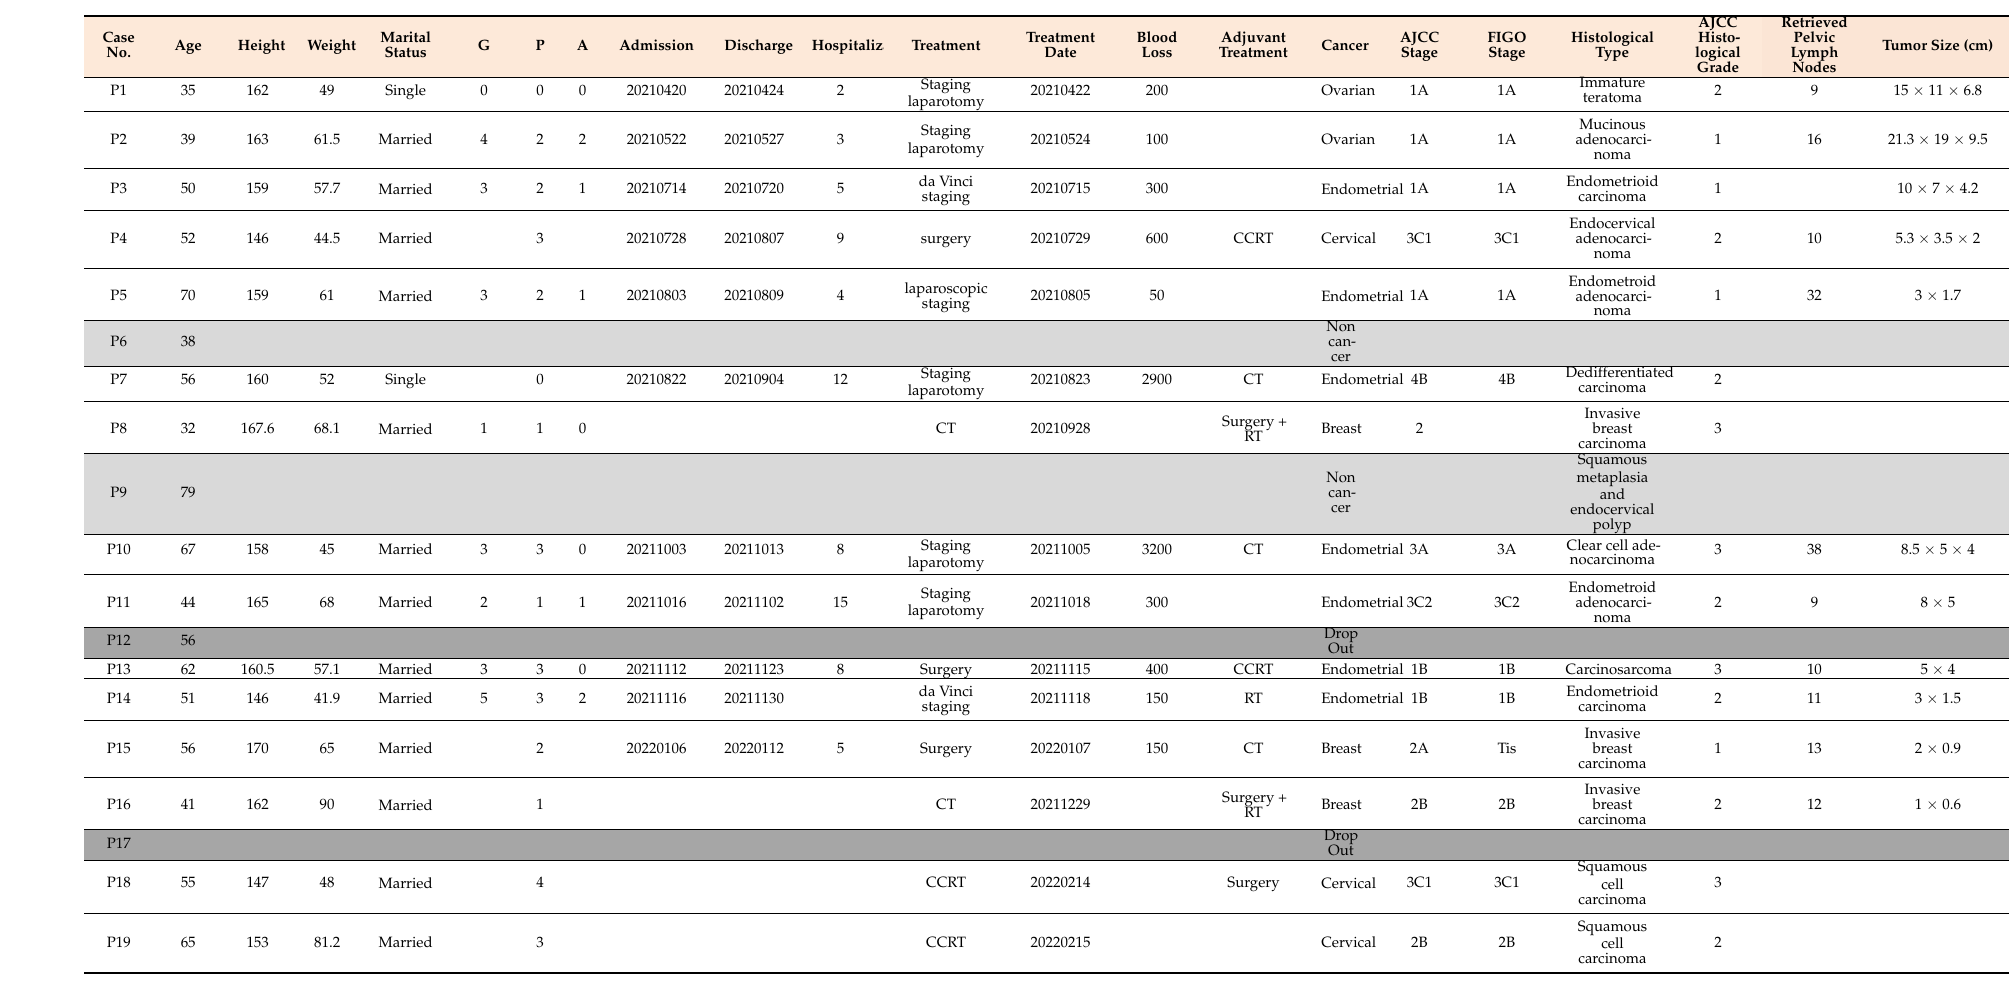
Table 1. Patient demographic characteristics. Patients were numbered according to the date of